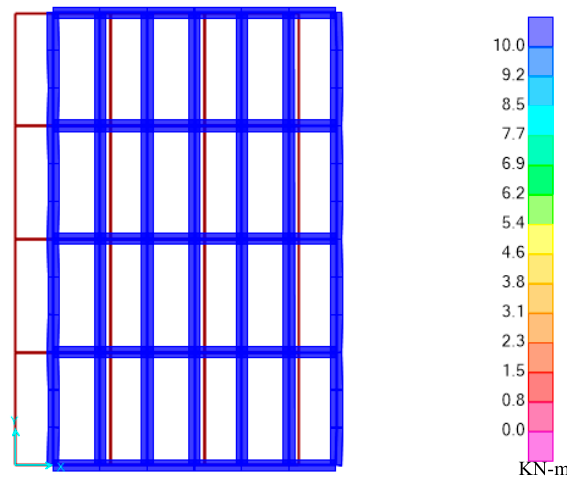
Figure 7. Illustration of the joint system of an Ammatoan vernacular house.